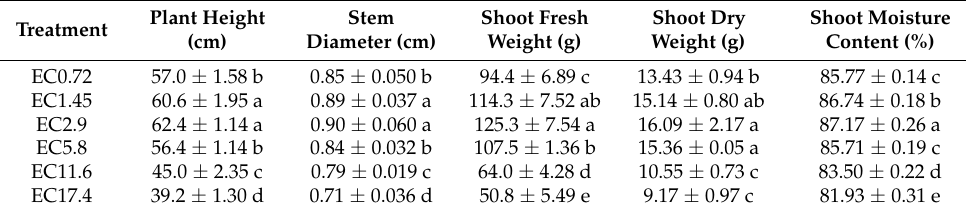
Table 1. Effects of different EC on the growth of sweet pepper after 25 days of